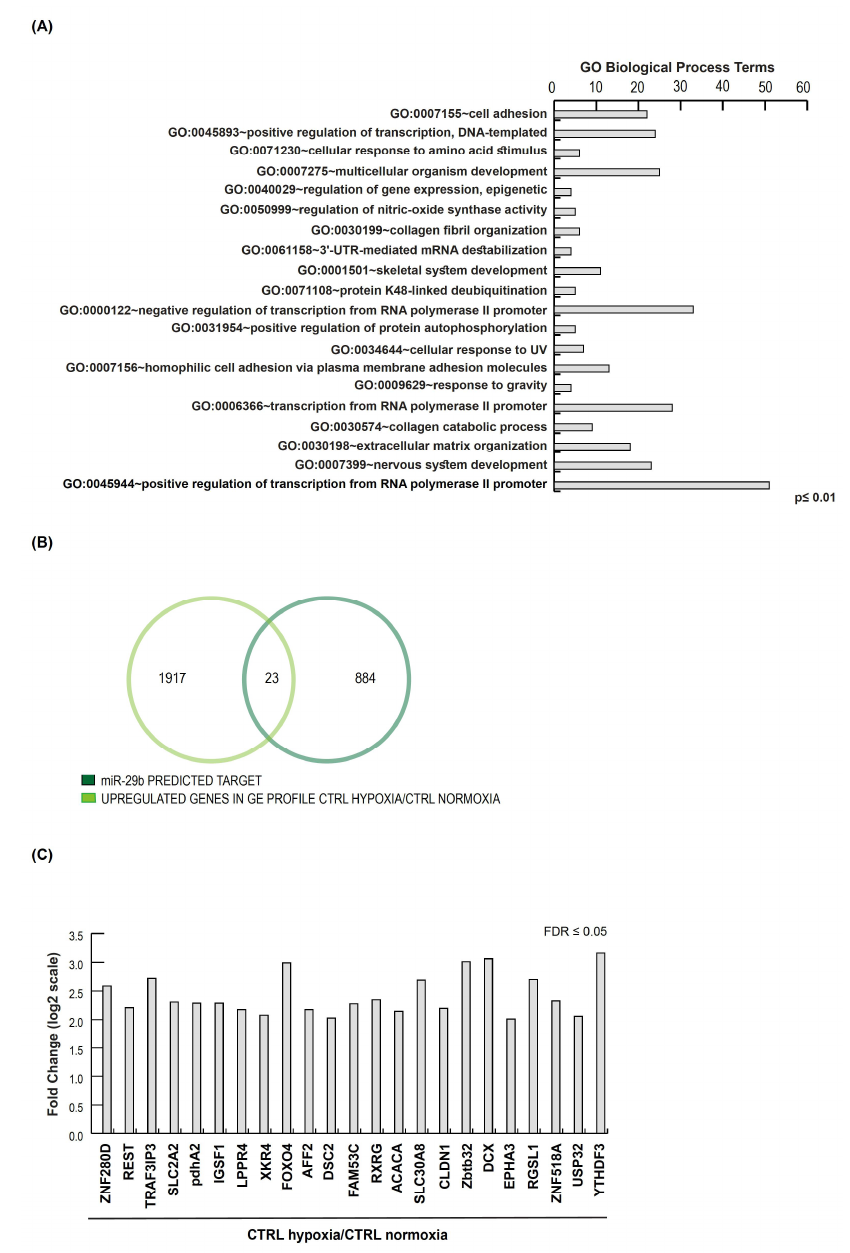
Figure 3. ( A ) GO term classification of 502 common hits intersecting the 907 predicted miR-29b target genes with 34017 experimentally defined regulated genes in GE microarray CTRL HYPOXIA/CTRL NORMOXIA (FDR ≤ 0.05 and FC ≥ 2). ( B ) Venn diagram showing 23 common genes between 907 predicted miR-29b target genes and 1940 upregulated genes in GE microarray CTRL HYPOXIA/CTRL NORMOXIA (FDR ≤ 0.05 and FC ≥ 4). ( C ) Fold change of microarray expression levels in log2 scale of 23 common genes.